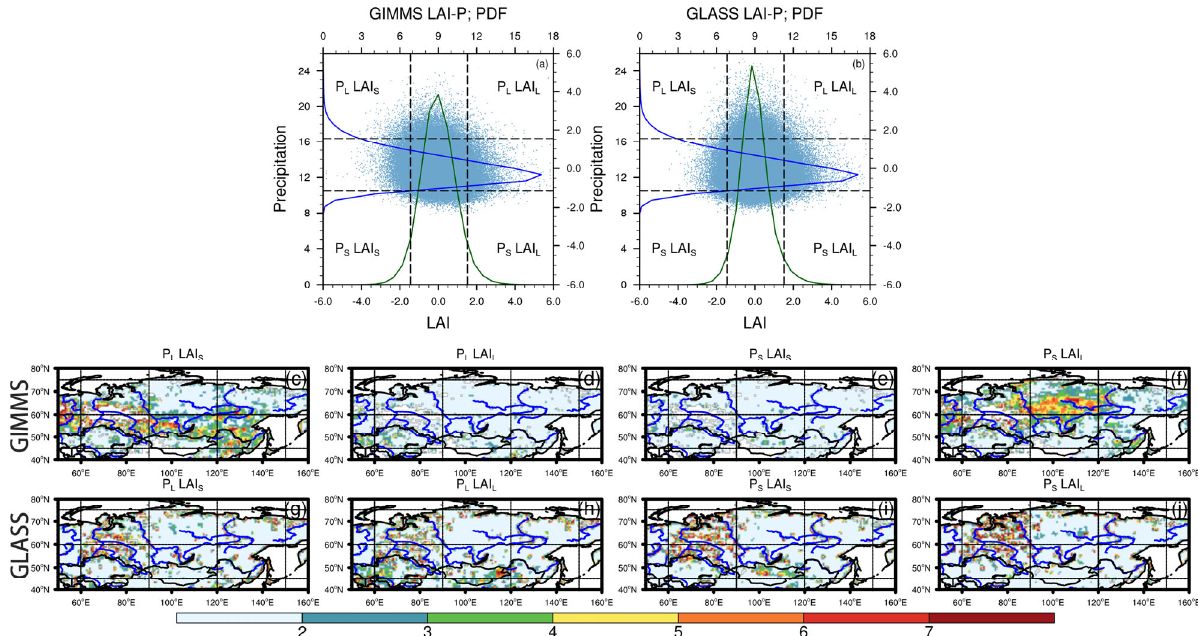
Figure 10. Same as Figure 7, but for the precipitation–LAI relationship. ( a , b ) Scatter plot of the precipitation and LAI with their probability distributions overlaid (lines). The black dashed lines mark the of 5th and 95th percentiles. The subscripts “L” and “S” represent values of the variables larger than the 95th percentile and smaller than 5th percentile, respectively. ( c – j ) Frequencies of the 4 ‐ compound extreme LAI vs. extreme precipitation situations (GIMMS LAI: a , c – f ; GLASS LAI: b , g – j ). LAI: ( b , g – j